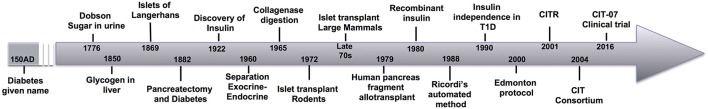
A historical timeline of significant events in the progression of scientific investigation culminating in the successful clinical trials of islet allotransplantation.